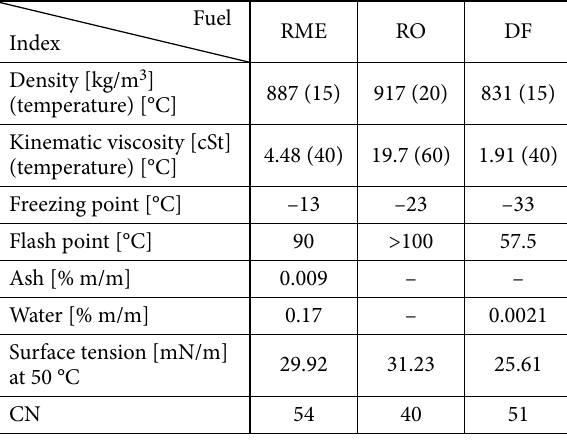
Table 1. Physical-chemical properties of fuels